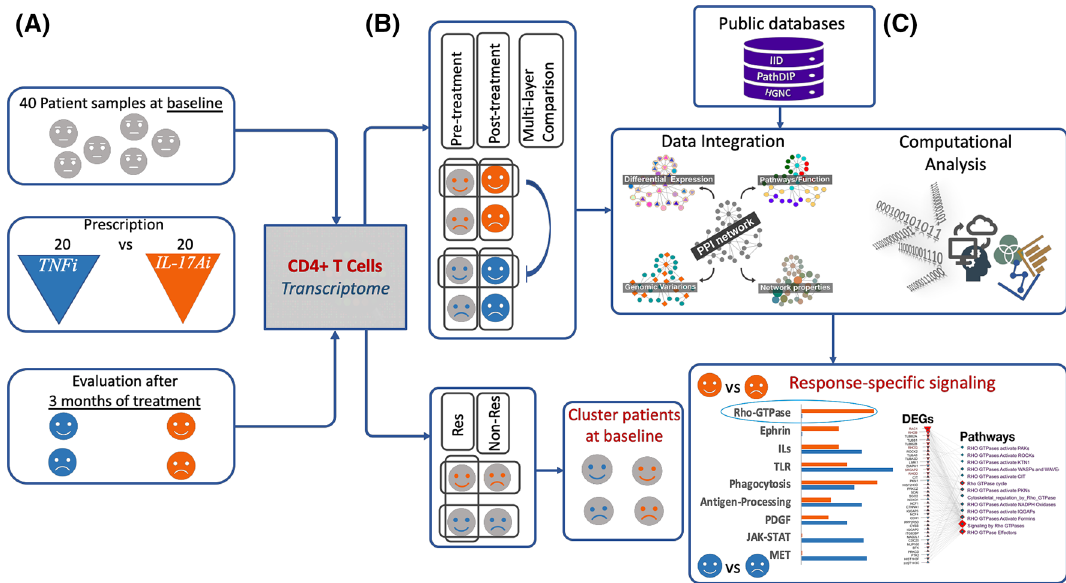
Figure 1. Schematic overview of study. ( A ) CD4 + T-cell transcriptomes of 40 patients with active PsA, at baseline and 3 months after treatment with TNFi or IL-17Ai. ( B ) Hierarchical clustering and PCA analysis clearly distinguished response groups. ( C ) Since the protein products of deregulated genes perform in groups, their physical connectivity can bring an additional layer of confidence to selection of genes whose statistical significance may not reflect their importance due to small sample size. We developed a multilayer analysis approach that annotates protein interactions with DEGs, protein families, and pathways. Our analysis identified signaling pathways likely involved in response to each biologic.